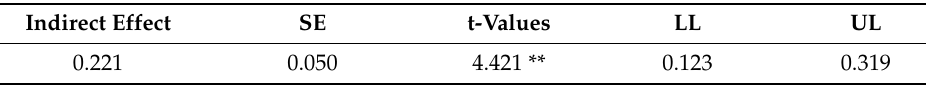
Table 5. Bootstrapped confidence interval